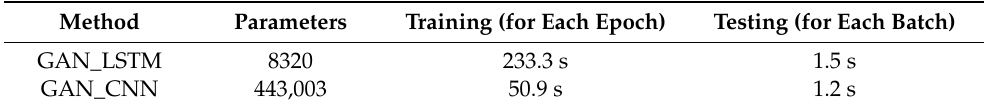
Table 8. Comparison of Time